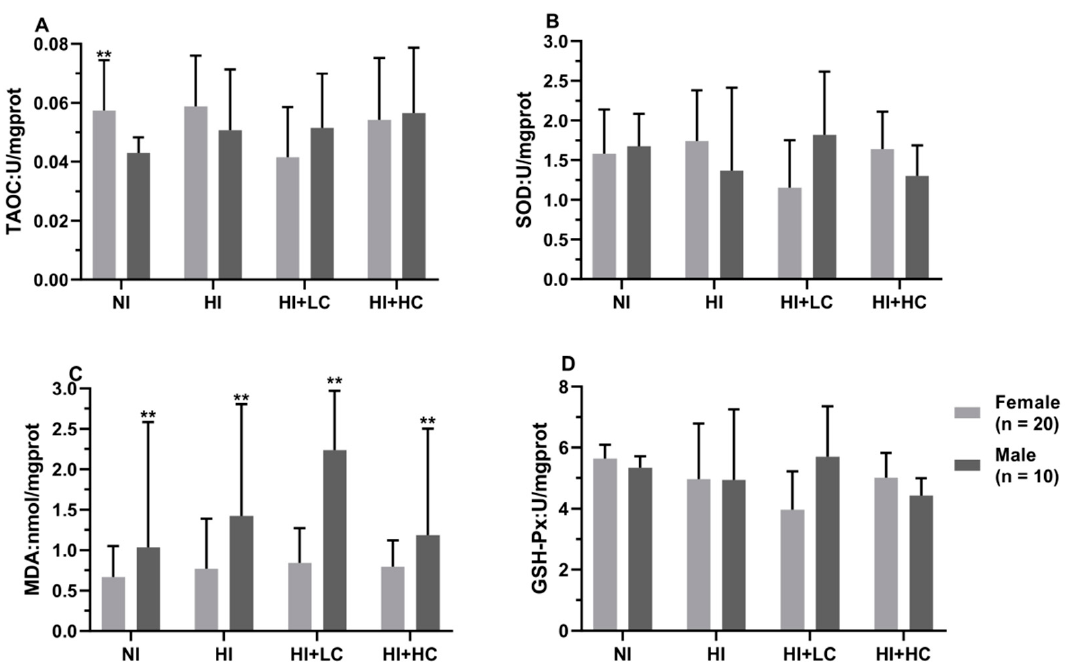
Figure 6. Protection of vitamin C from oxidative damage in the lens for different sexes. ( A ) The activity of TAOC; ( B ) The activity of CAT; ( C ) The activity of SOD; ( D ) The activity of GSH-Px. All data are presented as mean and deviation. ** represents the difference between female and male being statistically significant, and p < 0.01.